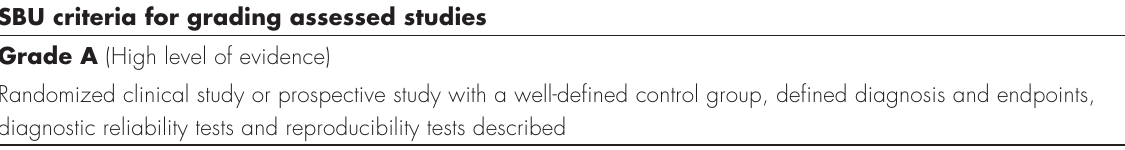
Table II. Swedish council on technology assessment in health-care (SBU) criteria for grading assessed studies. SBU criteria for grading assessed studies Grade A (High level of evidence) Randomized clinical study or prospective study with a well-defined control group, defined diagnosis and endpoints, diagnostic reliability tests and reproducibility tests described Grade B (Moderate level of evidence) Cohort study or retrospective case series with defined control or reference group, defined diagnosis and endpoints, diagnostic reliability tests and reproducibility tests described Grade C (Low level of evidence) Large attrition, unclear diagnosis and endpoints, poorly defined patient